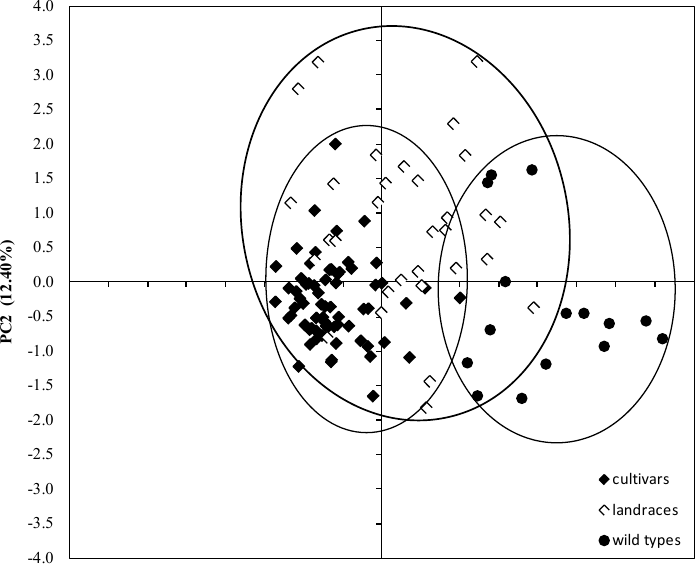
Fig. 1. Scatter plot of the observation scores of the first two principal components PC1 and PC2 obtained using the analytical data and accounting for about 75% of total variance of a tetraploid wheat collection grown at Valenzano (Bari, Italy) in 2010. The accessions were grouped in cultivars (ssp. durum ), landraces (ssp. turanicum , ssp. polonicum , ssp. turgidum , ssp. carthlicum ) and wild types (ssp. dicoccum and ssp. dicoccoides